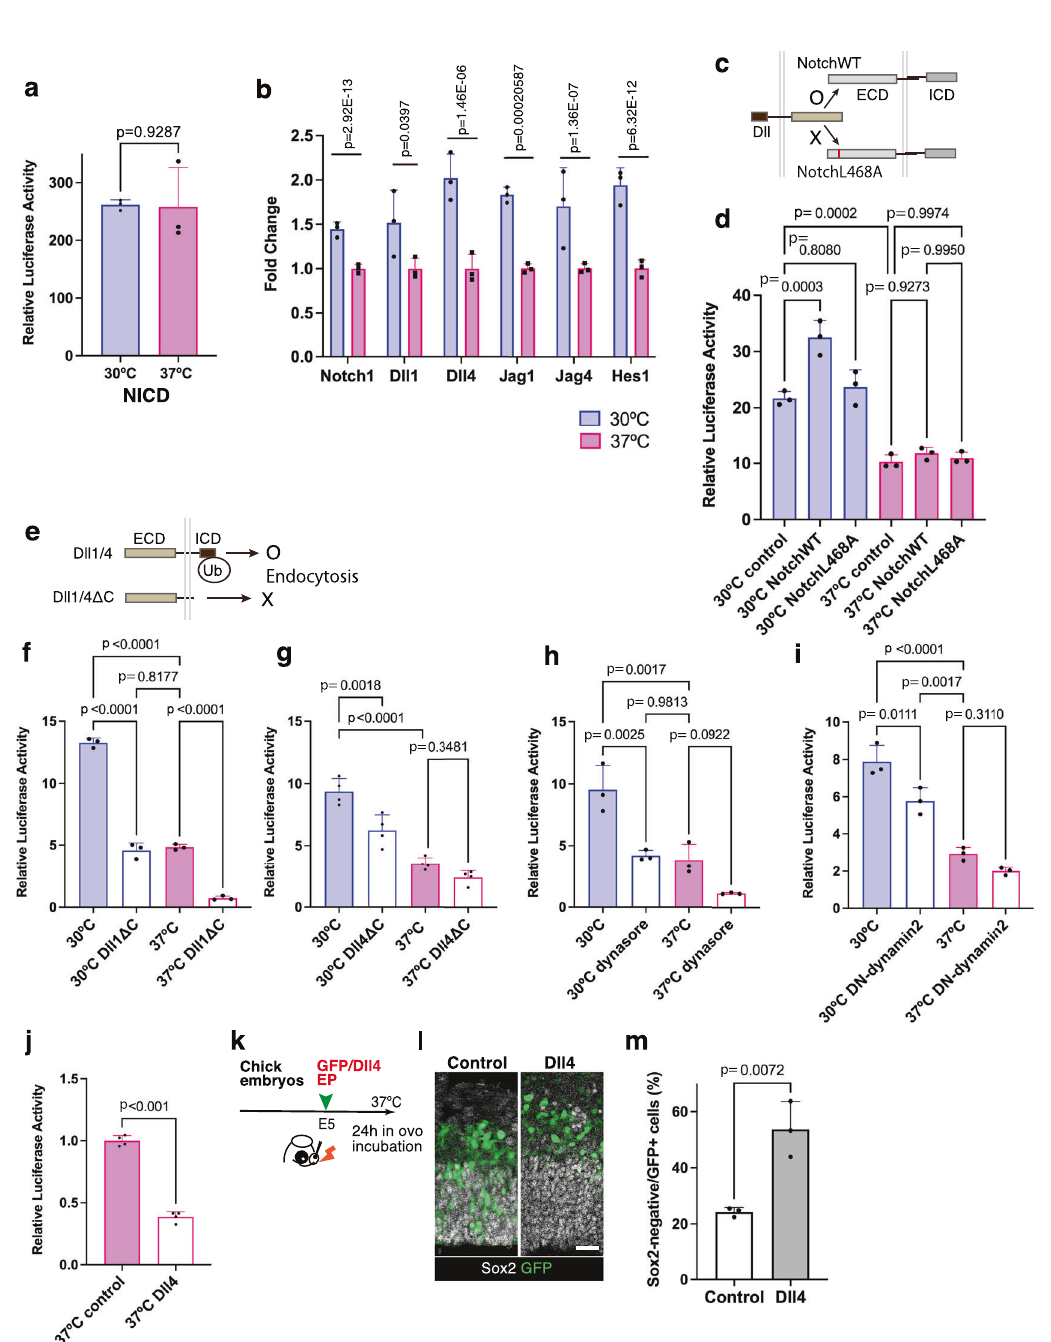
Fig. 1 Inverse temperature dependency of Notch activity in neural progenitors of oviparous animals. a , b Monitoring Notch activities in turtle ( a ) and chick ( b ) neural progenitors cultured at 30 °C or 37 °C for 24 h. A Notch reporter vector (4xCSL-luc) was introduced to isolated neural progenitors prior to culture. c , d Notch reporter activities in turtle ( c ) and chick ( d ) neural progenitors cultured at 30 °C or 37 °C (mean + SD, n = 3 biologically independent samples in each group). e DAPT treatment suppressed Notch activity in chicken neural progenitors cultured at 30 °C (means + SD, n = 5 biologically independent samples in each group). f NICD contents of chick neural progenitors cultured at different temperatures. g Schematic illustration of the temperature shift experiment in developing chick embryos. h – k Distribution of Sox2 and/or EdU-positive cells in the developing chick pallium incubated at 30 °C ( h , j ) or 37 °C ( i , k ). Insets represent Sox2-positive or negative EdU-labeled cells. l The proportion of Sox2-negative and EdU-positive cells in the chick pallium incubated at different temperatures (means + SD, n = 3 biologically independent samples in each group). m Schematic illustration of DN- MAML1 or NICD overexpression in the developing chick pallium. n Distribution of GFP-positive cells in GFP control, DN-MAML1- or NICD-overexpressing chick pallium incubated at 30 °C or 37 °C. o The proportion of Sox2-negative and GFP-positive cells in controls (30 °C or 37 °C), and DN-MAML1- or NICD-overexpressing chick pallium at 30 °C or 37 °C (means + SD, n = 3 biologically independent samples in each group). Two-sided, unpaired t -test for c , d , e , and l ; ordinary one-way ANOVA for o ( p -values were adjusted by Tukey test for multiple comparisons). P -values are indicated in each graph. Scale bars: 25 µ